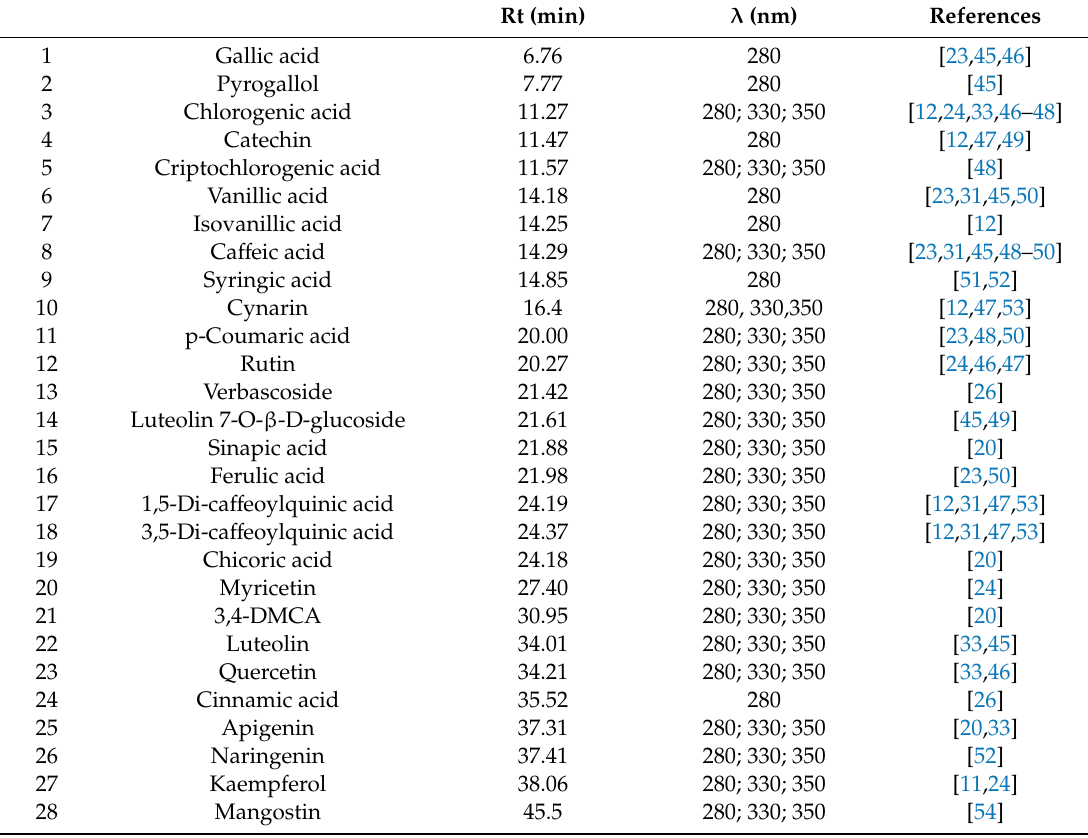
Table 7. Phenolic compounds identified in Parthenium genus and members of the Asteraceae family screened in leaf and twig extracts of guayule by